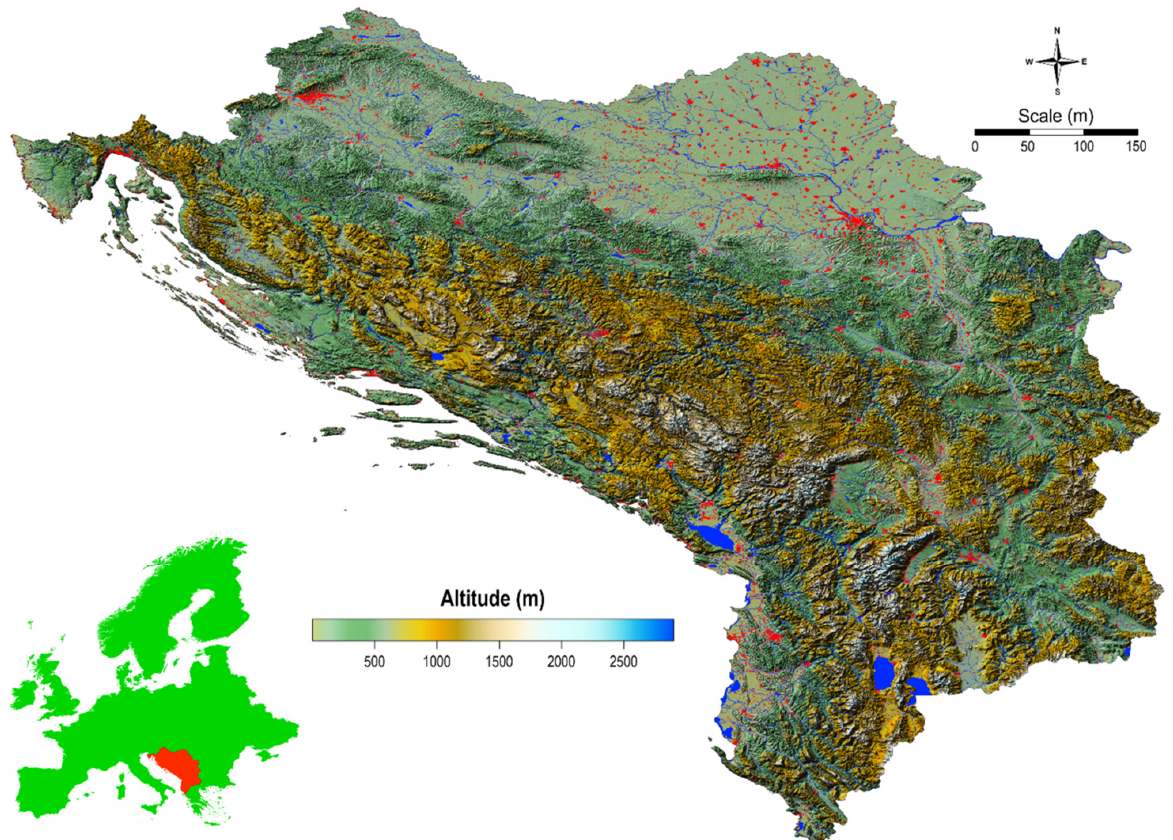
Figure 1. Digital elevation model of the West Balkan region.